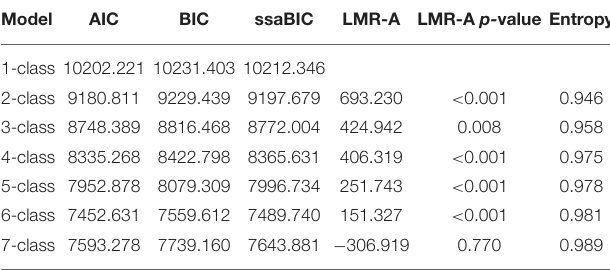
TABLE 2 | Fit of competing latent profile models.